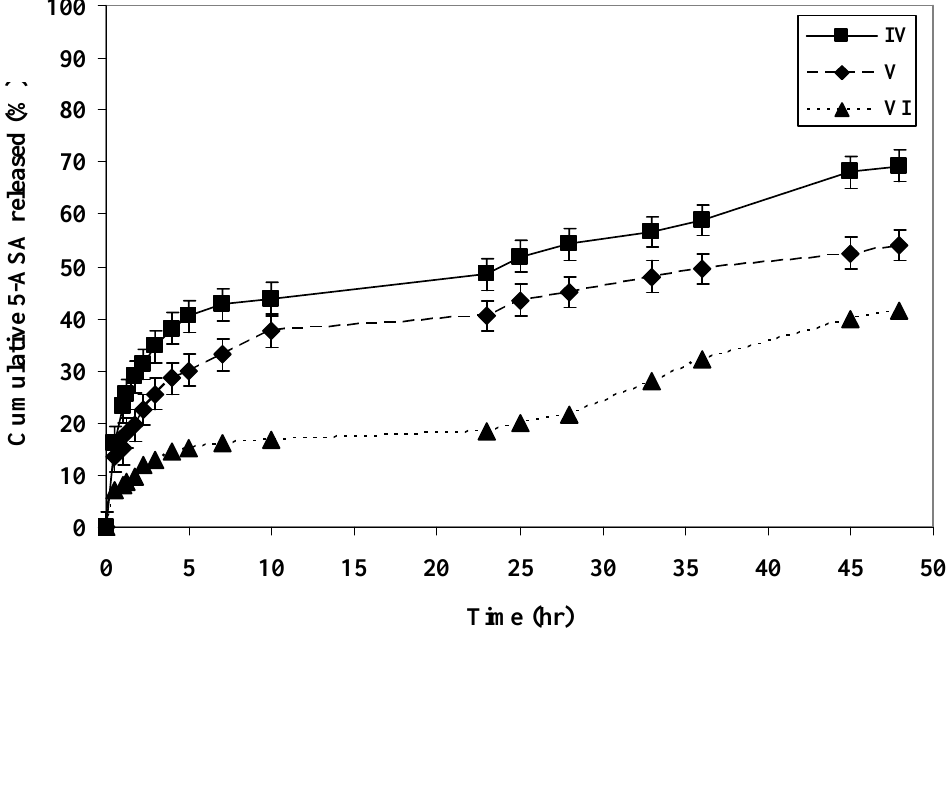
Figure 4. In vit ro 5-ASA release from polymers IV-VI in phosphate buffer solution (pH 7.8) at 37